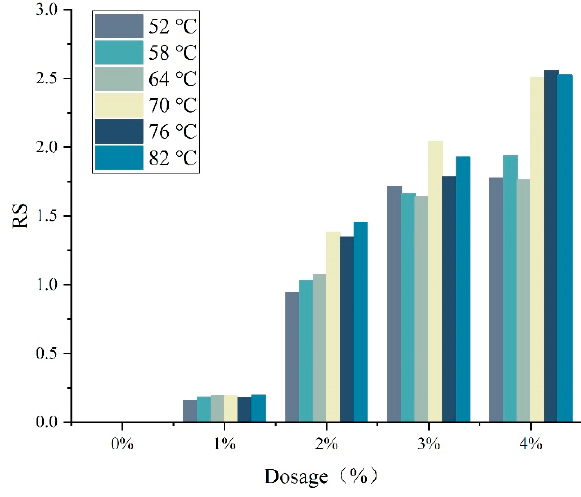
Figure 8. DM-modified asphalt RS index result.